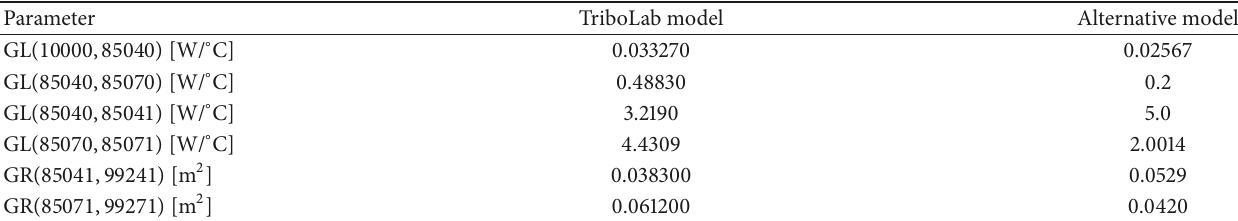
Table 12: TriboLab model definition.